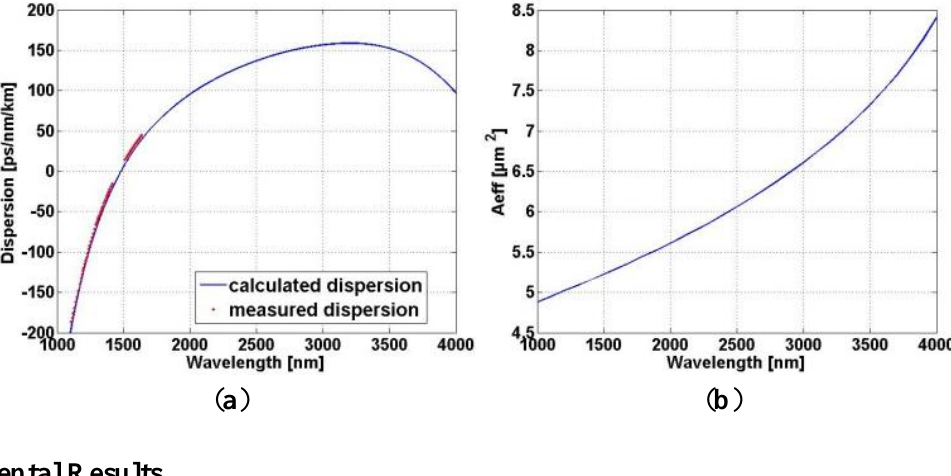
Figure 4. ( a ) Measured dispersion of the fundamental mode (dots) and calculated dispersion for real structure (solid line) of developed nonlinear PCF; ( b ) calculated wavelength dependence of the effective mode area of the fundamental